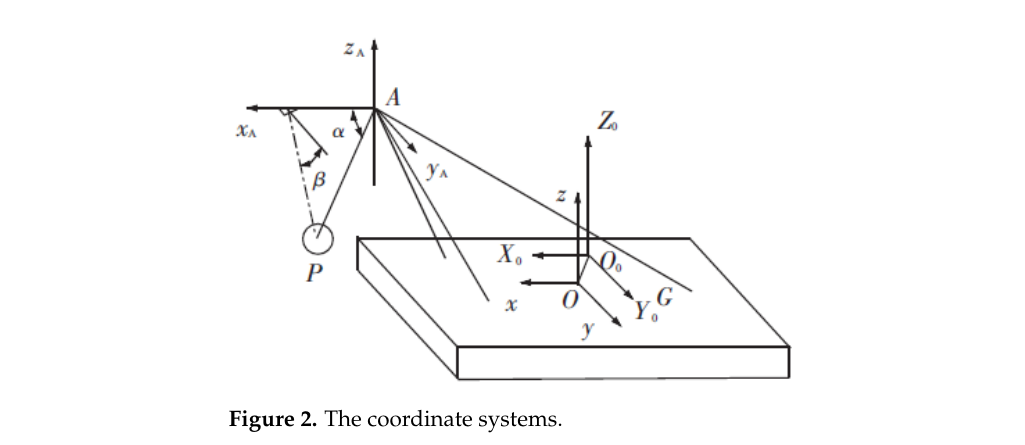
Figure 2. The coordinate systems.